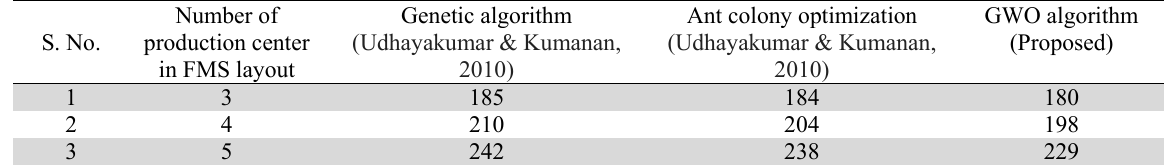
Comparison of the combined objective function yield for the three sizes of FMS layout S.